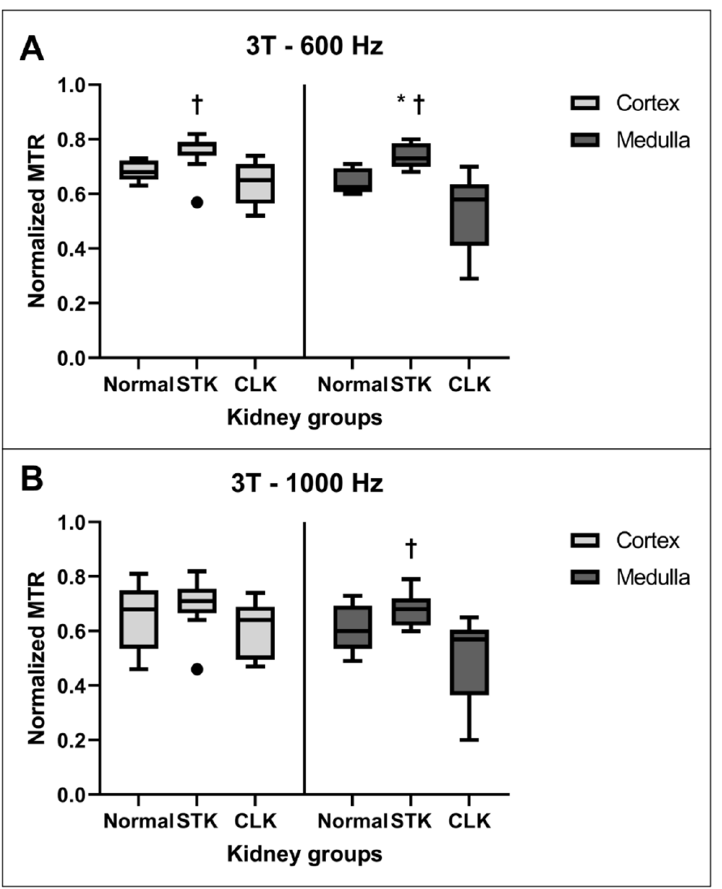
Figure 2. ( A ). Boxplots of normalized MTR values at the first timepoint at 3T with an offset frequency of 600 Hz for normal, stenotic (STK), and contralateral (CLK) kidneys in the cortex (left) and medulla (right). ( B ). Normalized MTR values at 3T with an offset frequency of 1000 Hz for the same kidneys. * p ≤ 0.05 vs. normal, † p ≤ 0.05 vs. CLK.